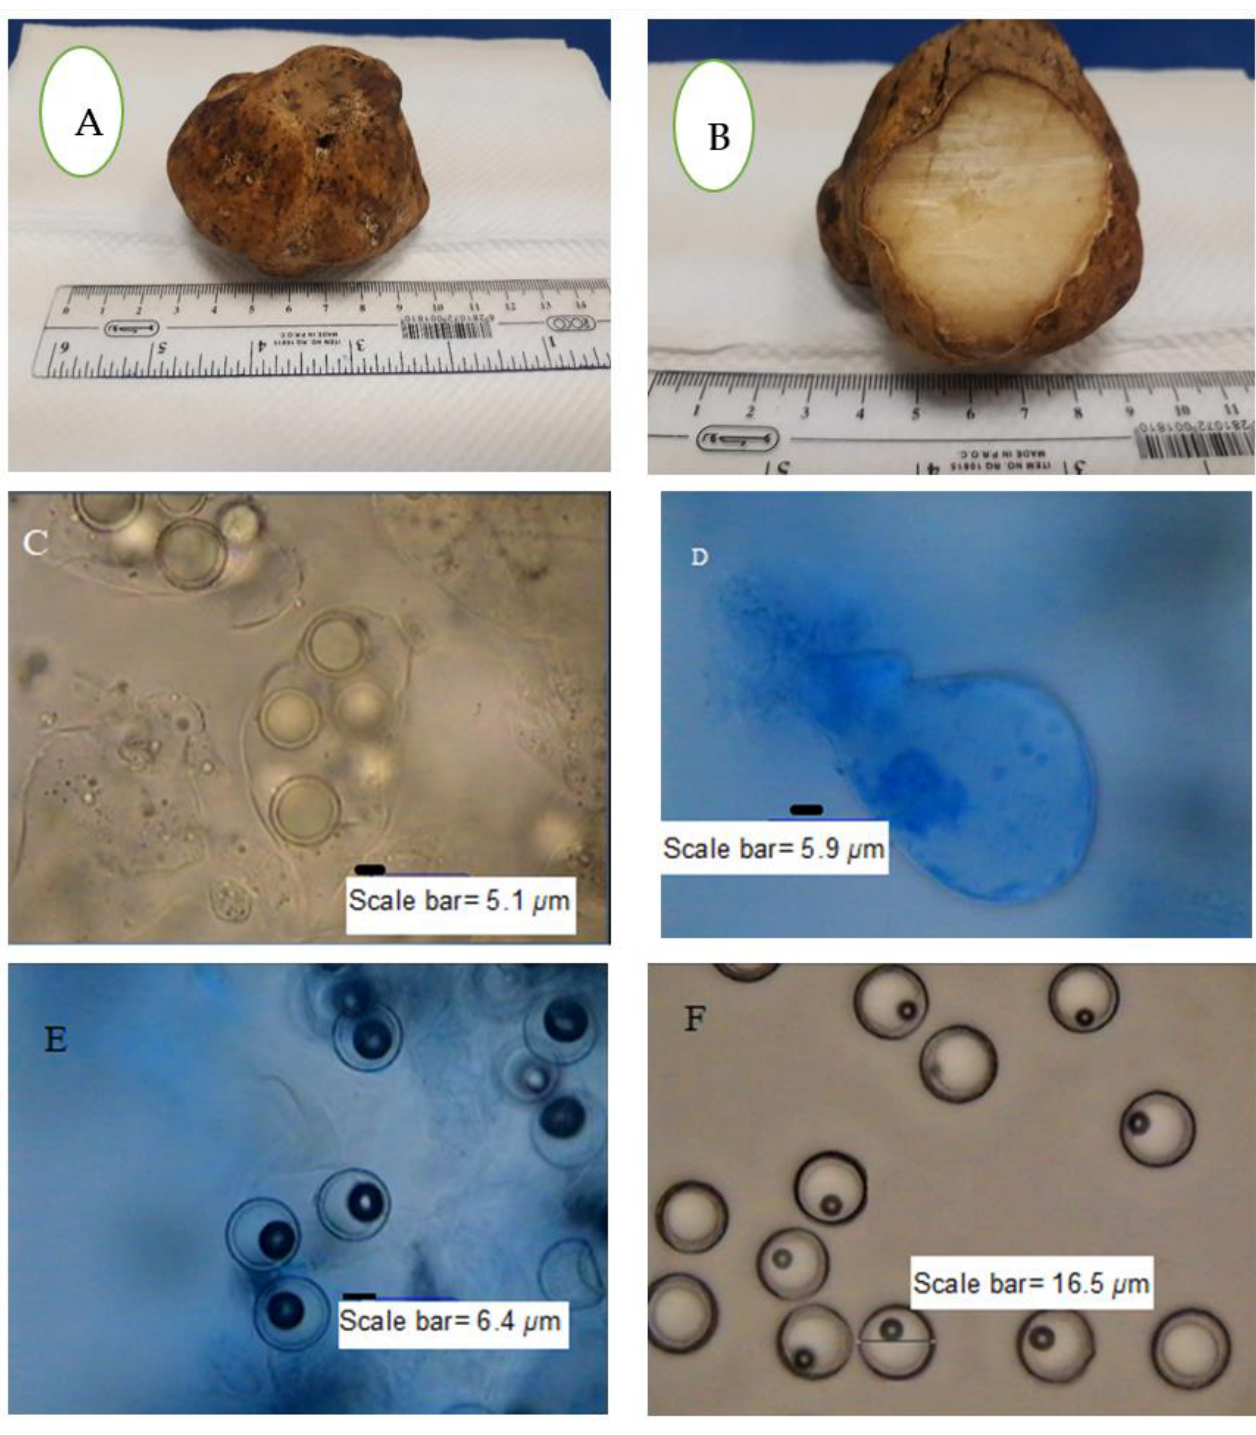
Figure 1. Macroscopic and microscopic features of T. nivea . ( A ) Whole fruiting body, ( B ) sporocarp (fruiting body) internal view, ( C ) ascus with aeciospores, ( D ) ascospore-free ascus stained with lactophenol cotton blue, ( E ) free ascospores strained with lactophenol cotton blue and ( F ) free ascospores without stain.